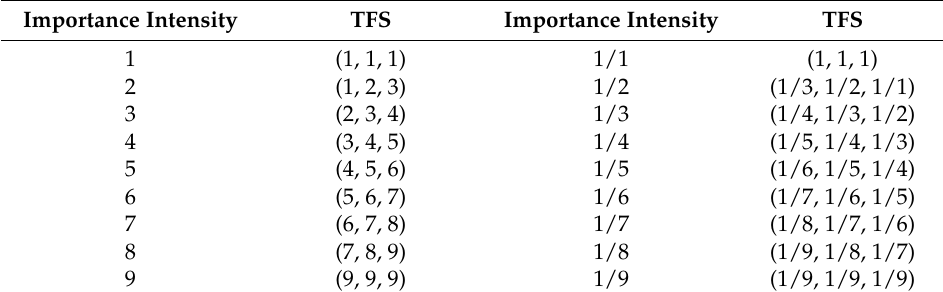
Table 1. Triangular fuzzy scale